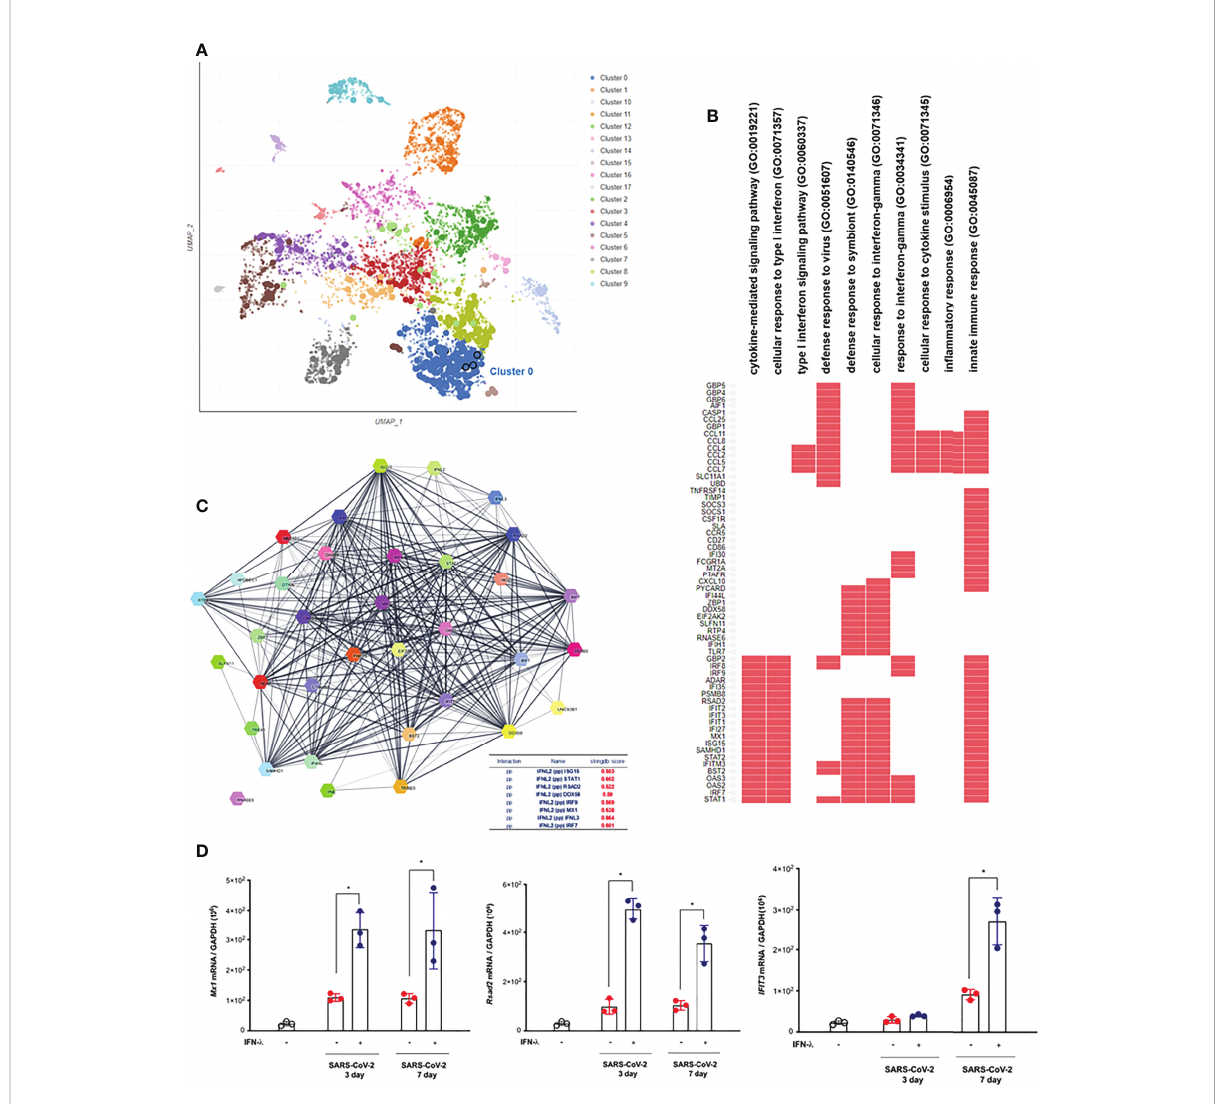
FIGURE 5 Intranasal inoculation of IFN- l s leads to a strong induction of IFN-stimulated genes (ISGs) in the lungs of CoV2+ hamsters. Syrian golden hamsters were infected with SARS-CoV-2 and concomitantly treated with recombinant IFN- l (IFN- l 2 : 5 m g, IFN- l 3 : 5 m g with PBS 30 m l) at 3 and 7 dpi [CoV2- (N = 3)/CoV2+ 3 dpi (n = 3)/CoV2+ 3 dpi with IFN- l (N = 3)/COV2+ 7 dpi (N = 3)/CoV2+ 7 dpi with IFN- l (N = 3)]. EnrichR analysis was performed to determine the DEGs in the lungs of CoV2+ hamsters depending on the inoculation of IFN- l s. (A) The scatter plot of EnrichR data revealed that 3,498 DEGs were classi fi ed into 18 clusters linked to biological process, and the top 10 signi fi cant GO terms were included into cluster 0. (B) The GO terms in cluster 0 were plotted according to their p -value ranking. (C) Protein – protein interaction (PPI) network of the DEGs linked to “ response to IFN ” indicates the PPI among IFN- l and the ISGs (PP: protein – protein). (D) Mx1 , Rsad2 , and I fi t3 mRNA levels were determined by real-time PCR at 3 and 7 dpi in SARS-CoV-2-infected lungs from animals that also received an intranasal inoculation of IFN- l . The real-time PCR results were analyzed by the Mann – Whitney U test and are presented as mean ± SD values from three independent experiments. * p < 0.05 vs. non-infected